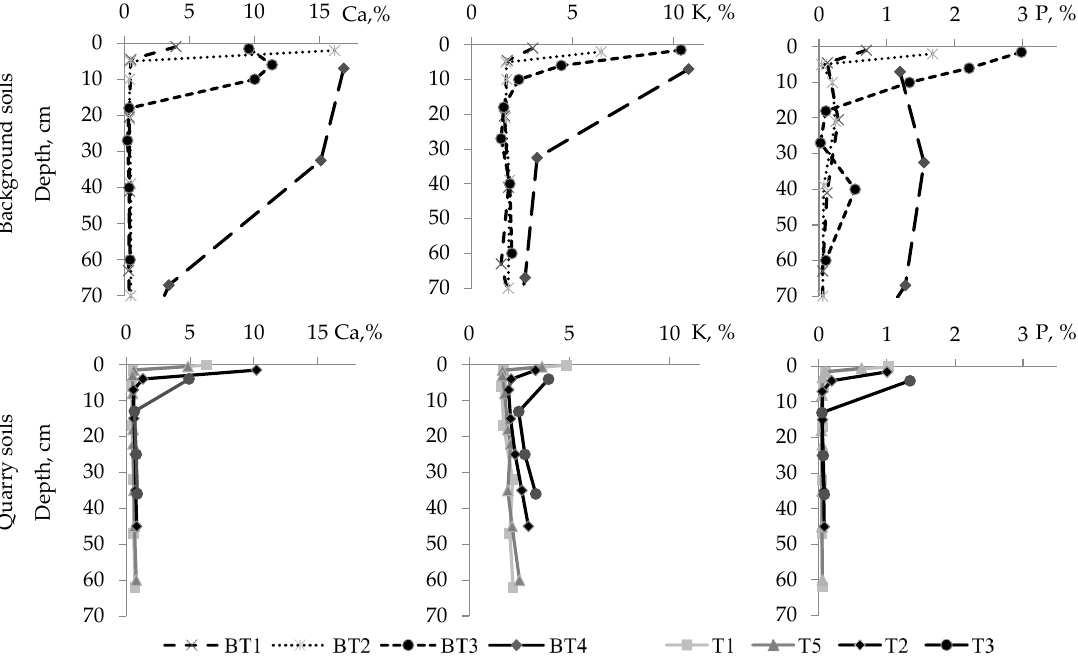
both in the organic-mineral horizons and in the mineral profile part (Figure 4).